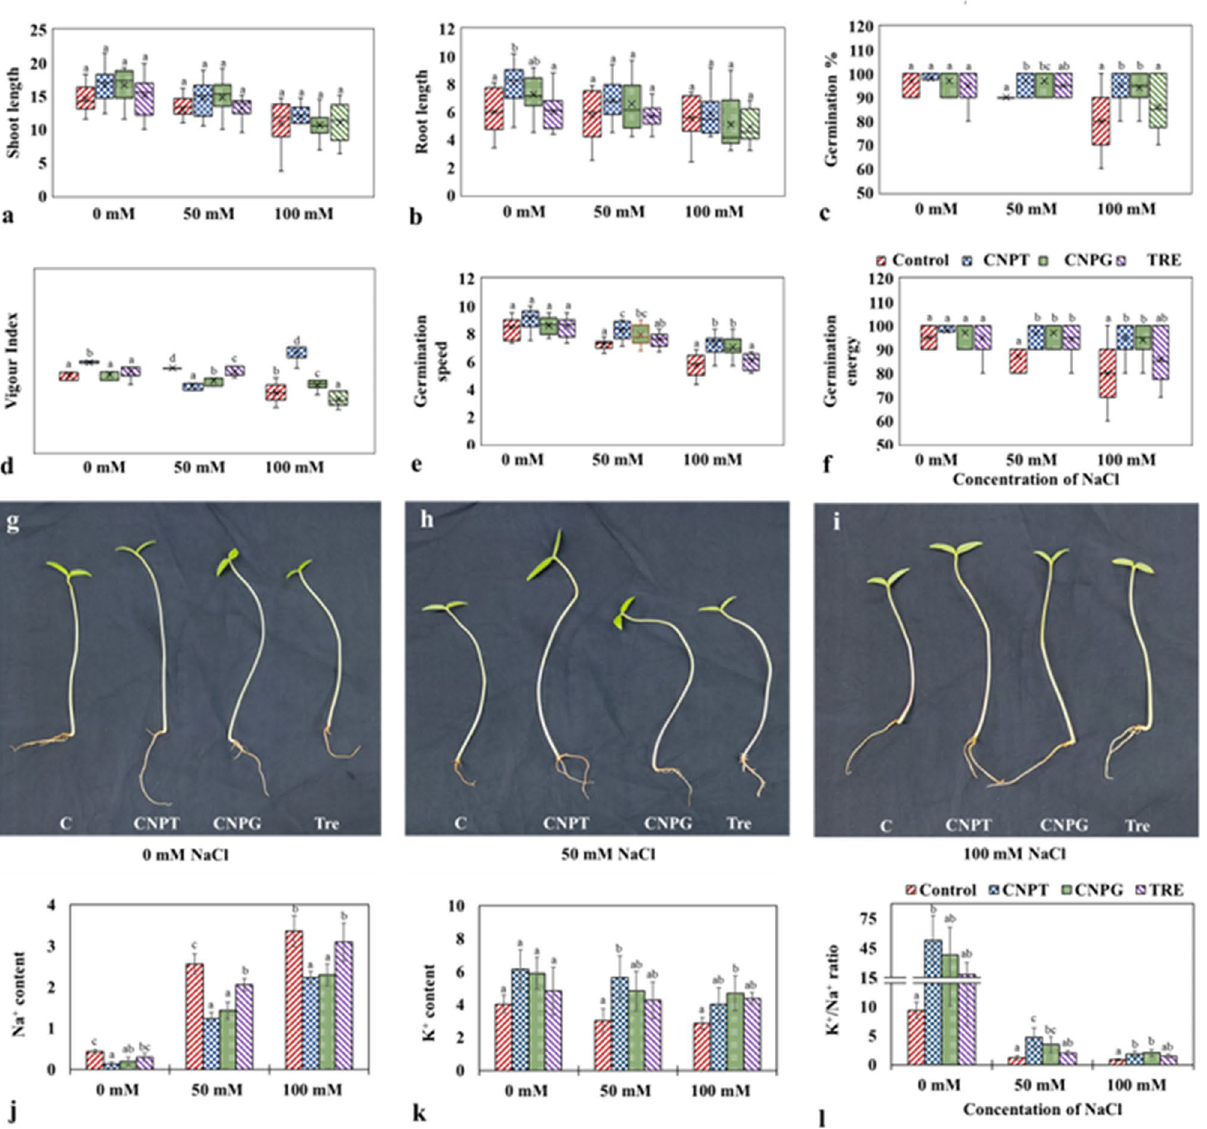
Figure 3. Changes in morphology, germination traits and ionic status of NaCl stressed Vigna radiata seedlings following the application of CNPT, CNPG and TRE. ( a ) Shoot length (cm); ( b ) Root length (cm); ( c ) Germination percentage; ( d ) Vigour index; ( e ) Germination speed (Seeds day -1 ); ( f ) Germination energy (%); ( g – i ) Images of seedlings after treatment with dH 2 O, CNPT, CNPG, and Trehalose under 0, 50, and 100 mM NaCl stress conditions; ( j ) Sodium content (mg g −1 f.w.t); ( k ) Potassium content (mg g −1 f.w.t); ( l ) Potassium/ Sodium